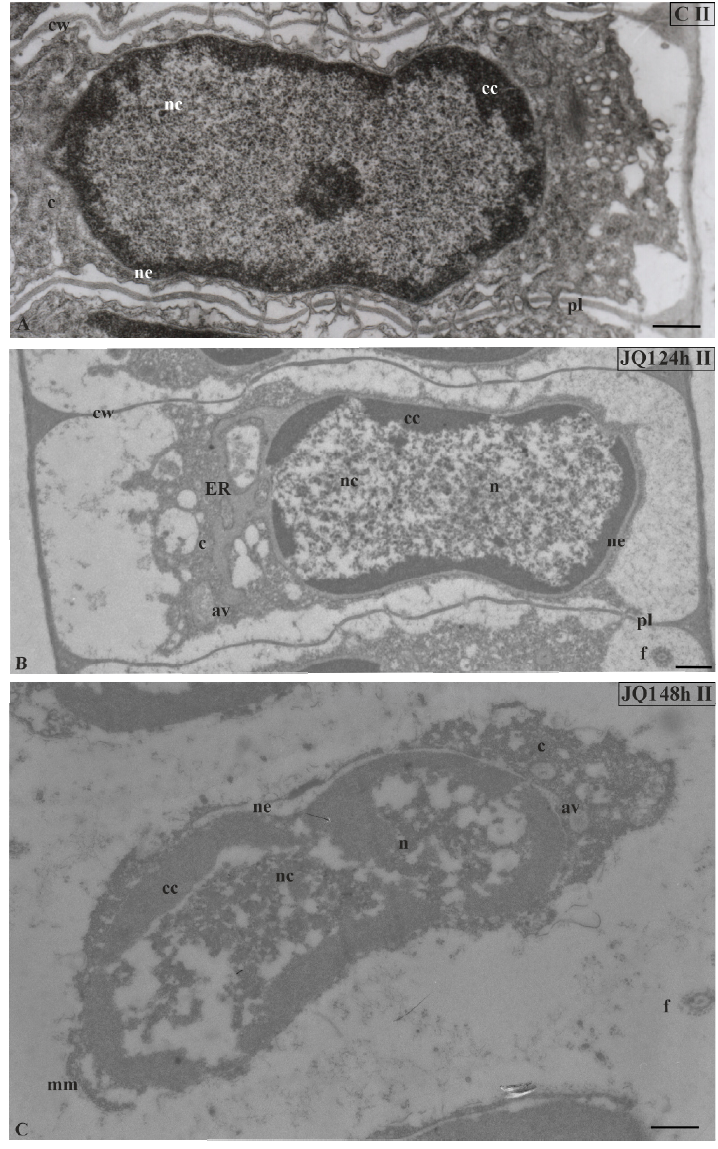
Figure 4. Ultrastructural changes in C. vulgaris spermatids at stage II; ( A ) the control; ( B ) after 24-h and ( C ) 48-h treatment with JQ1; changes in non-condensed chromatin and cytoplasm structure. In spermatids dilated nuclear envelope together with ER cisternae ( B ) and in nucleus loose spaces ( B , C ) are visible. Longitudinal section of spermatids; av, autolytic vacuole; c, cytoplasm; cc, condensed chromatin; cw, cell wall; ER, endoplasmic reticulum; f, flagellum; mm, microtubular manchette; n, nucleus; nc, non-condensed chromatin; ne, nuclear envelope; pl, plasmodesmata; on individual images in the frame treatment, time of treatment and stage of spermiogenesis were given; Scale bar = 500